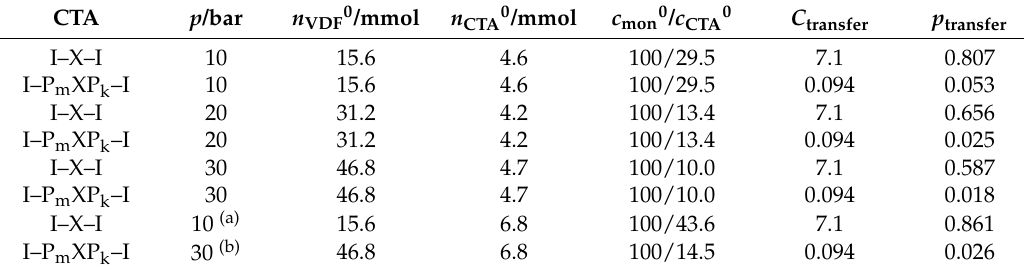
Table 4. Transfer probabilities for semi ‐ batch iodine transfer polymerizations for variation of pressure with X = C 4 F 8 : (a) pressure during the initial phase of the polymerization; (b) pressure in the second phase of the polymerization.